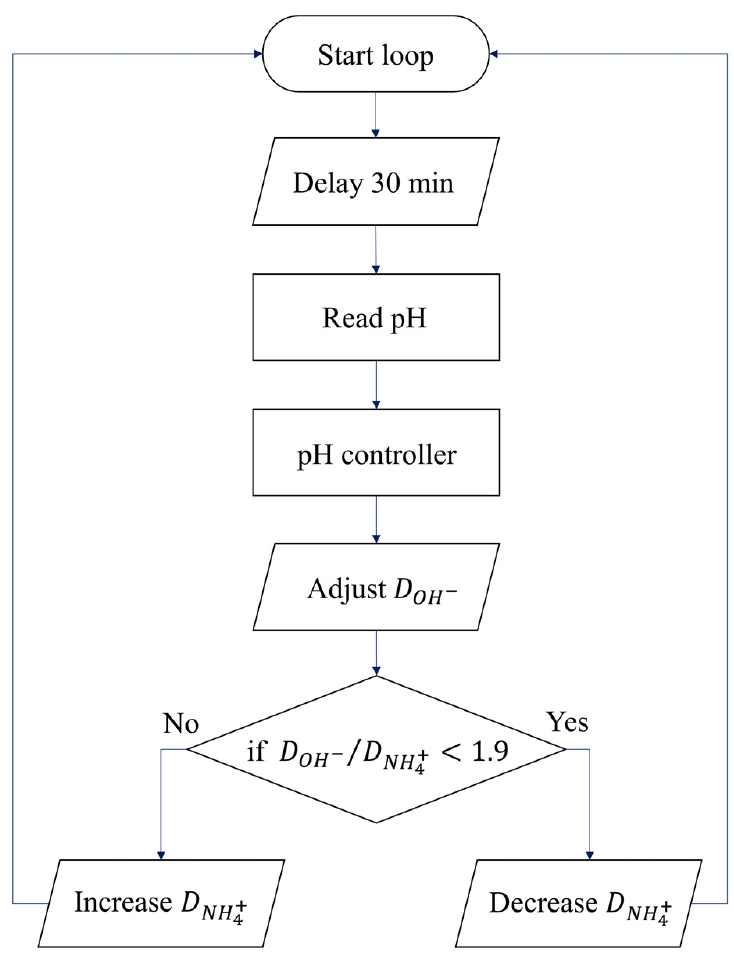
Figure 5. Sequential function chart of the control algorithm used in the fed-batch system. Designed to operate slightly to the right of “Target operating point” shown in Figure 4, the ammonium dosing rate is decreased when it is larger than υ max and increased when its smaller than υ max . A constant of 1.9 is specified (instead of 2) to account for calibration errors as discussed in the text.